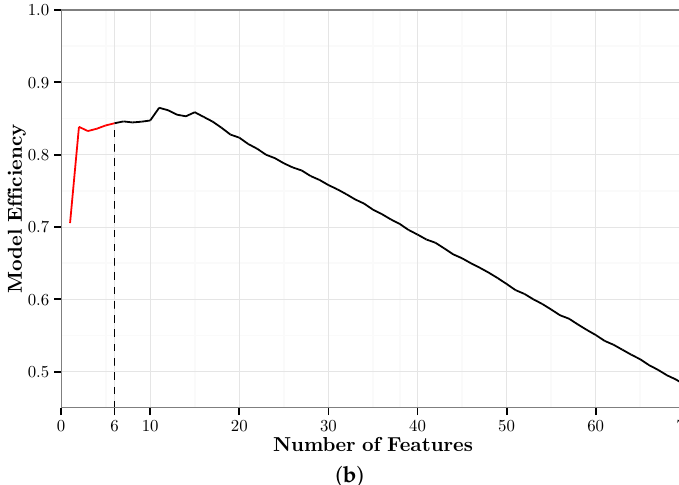
Figure 5. A graphical summary of the recursive feature elimination (RFE)- k NN models. ( a ) Ten-fold cross-validation accuracy of the RFE- k NN models. The solid black line represents the prediction accuracy; the solid red line represents the minimum cut-off accuracy for the optimal model; and the dashed black line represents the minimum number of features necessary to attain the cut-off accuracy. ( b ) Model efficiency metric of the RFE- k NN models. The red portion represents models that do not meet the cut-off accuracy; the black portion represents models that do meet the cut-off accuracy.